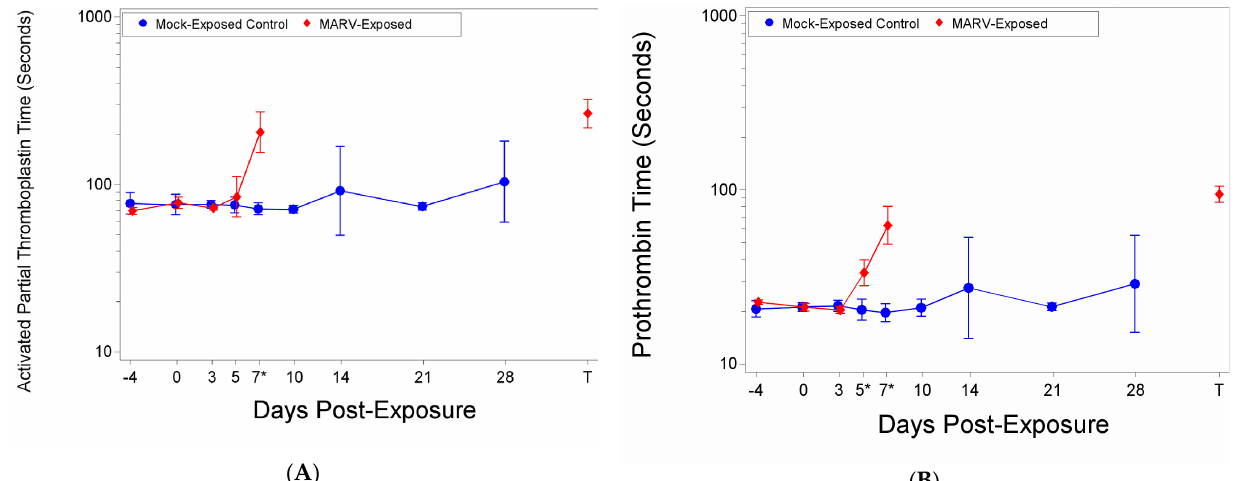
Figure 7. Coagulation Factors. ( A ) Activated Partial Thromboplastin time; ( B ) Prothrombin time. At each blood draw coagulation times were measured using a IDEXX Coag DxTM Analyze and IDEXX Coag Dx PT and aPTT cartridges. The symbols represent geometric mean times and bars indicate 95% confidence intervals. * indicates statistically significant difference in means ( p < 0.05) between MARV-exposed and mock-exposed control groups.